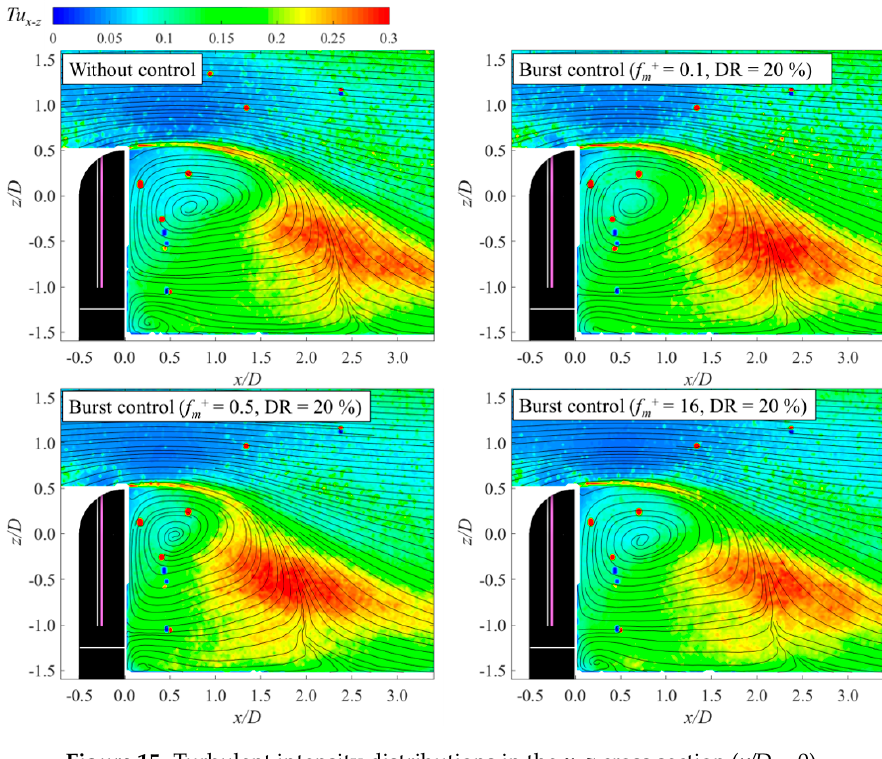
Figure 15. Turbulent intensity distributions in the x–z cross section ( y / D = 0).